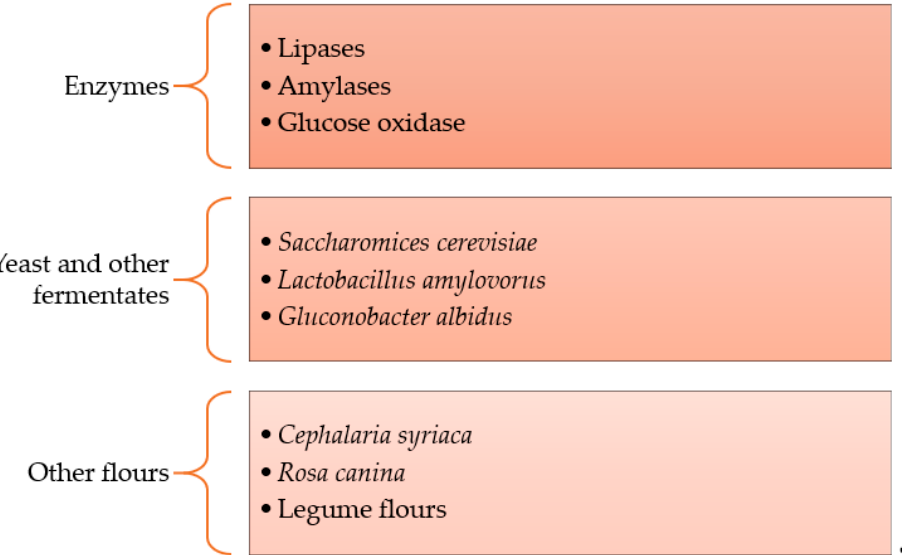
Figure 2. Summary of other strengthener options for clean-label formulations.